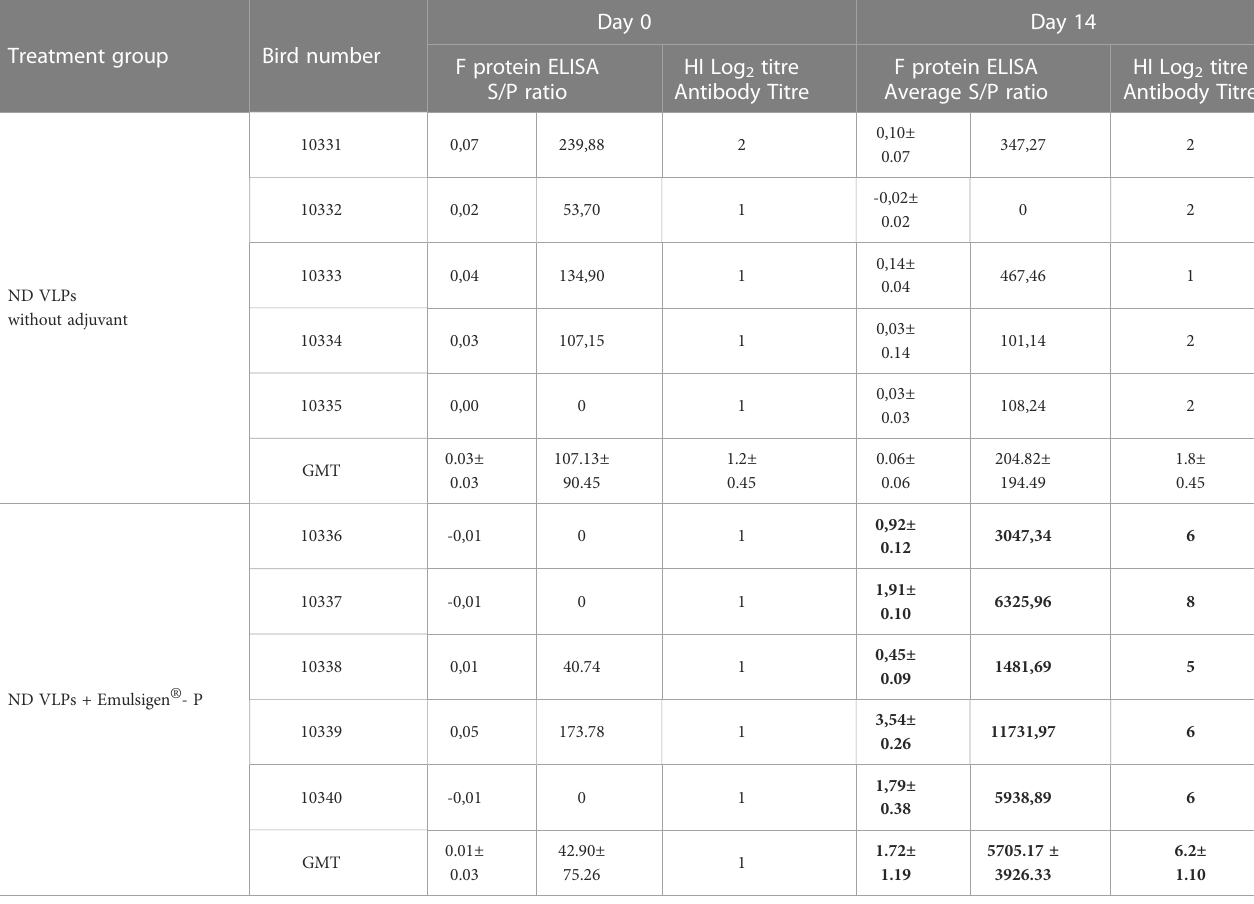
TABLE 1 Serology test results for speci fi c-pathogen-free chickens prior to vaccination and at 14 days post vaccination with positive values indicated in bold.